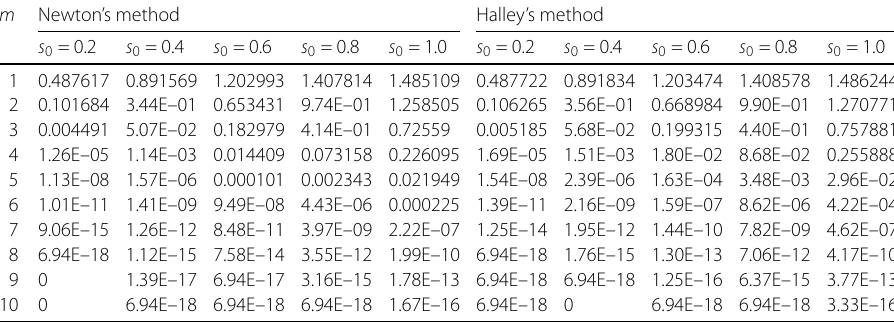
Table 7 Errors of shooting techniques |˜ F ( s m ) | in (41) versus the maximum number of iterations m with various initial approximations s 0 in Example 4.3 as we set α 1 = 0.4, α 2 = 1.7, h = 0.01